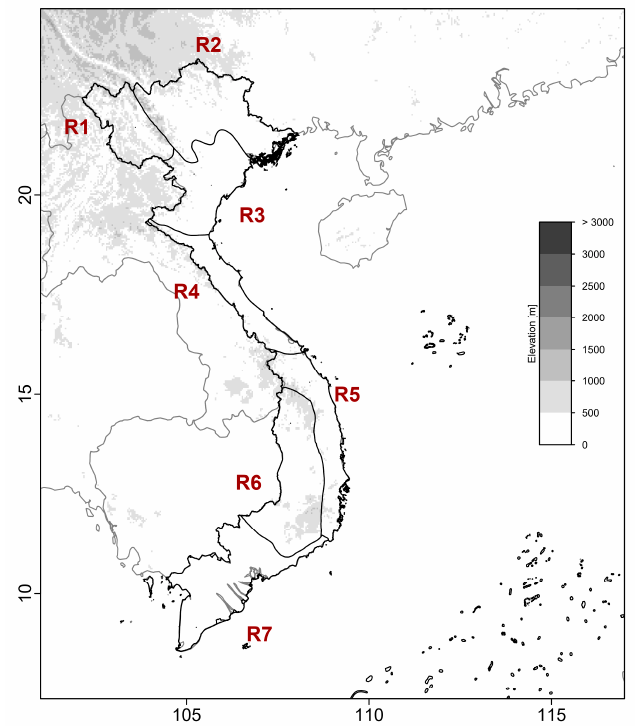
Figure 1. The seven climate regions of Vietnam (polygons bounded by black lines) as defined in the Vietnam Hydrometeorological Atlas. The elevation across these regions is also shown for reference.